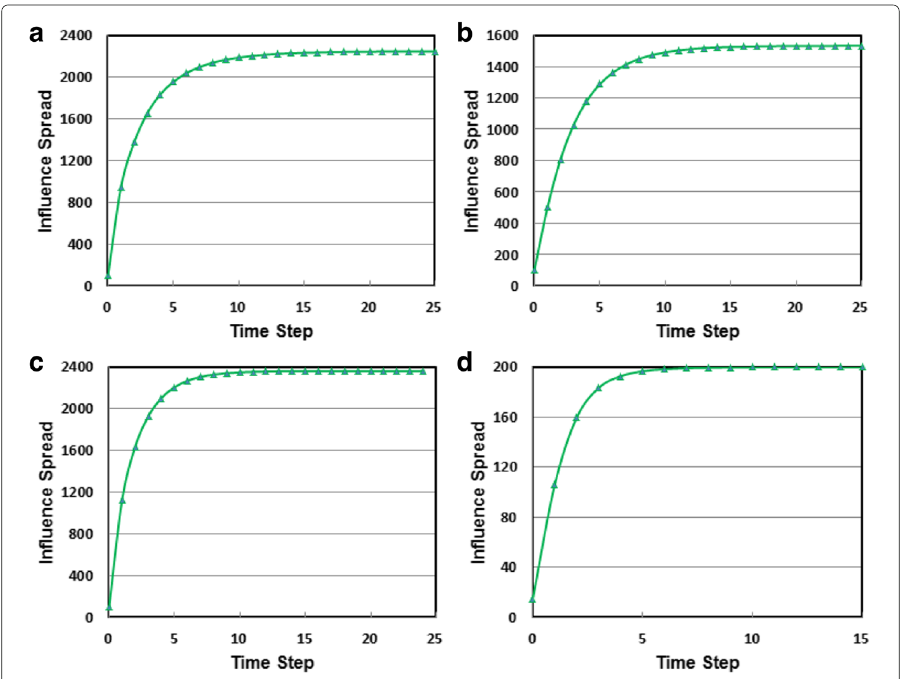
Fig. 3 Adoption rate achieved by IV-Greedy. a PGP dataset, b NetHEPT dataset, c WikiVote dataset, and d C.elegans dataset